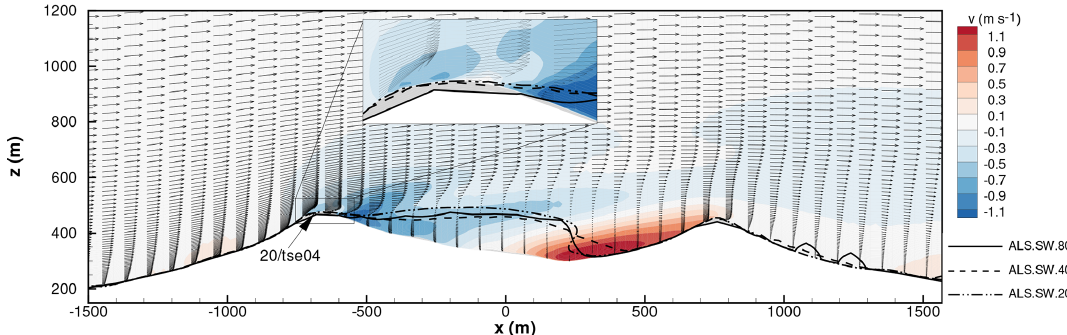
Figure 12. Impact of mesh resolution on separation zone in transect that crosses tower 20/tse04 in the case of SW winds.